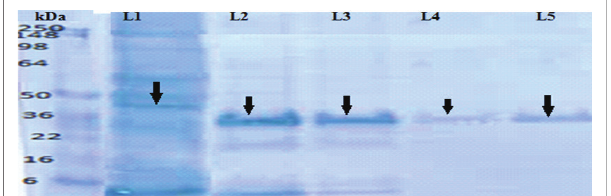
FIGURE 2-A1: Anti-His Western blot analysis illustrating purified recombinant 6 proteins (indicated with arrows). (kDa: Molecular weight marker with size indicated in kDa; L1: sub-fragment 1-2, L2: sub-fragment 3, L3: sub-fragment 4, L4: sub-fragment 5, L5: sub-fragment